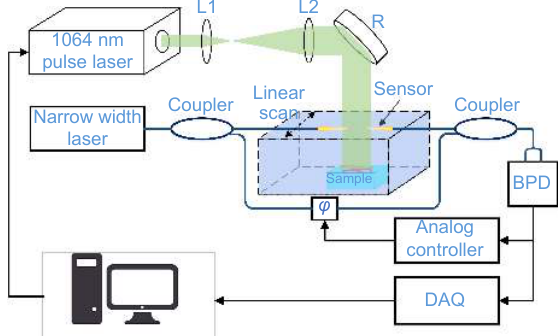
Fig. 6 | Schematic of the photoacoustic tomography imaging system. L1&L2: Lens. R: Reflector.